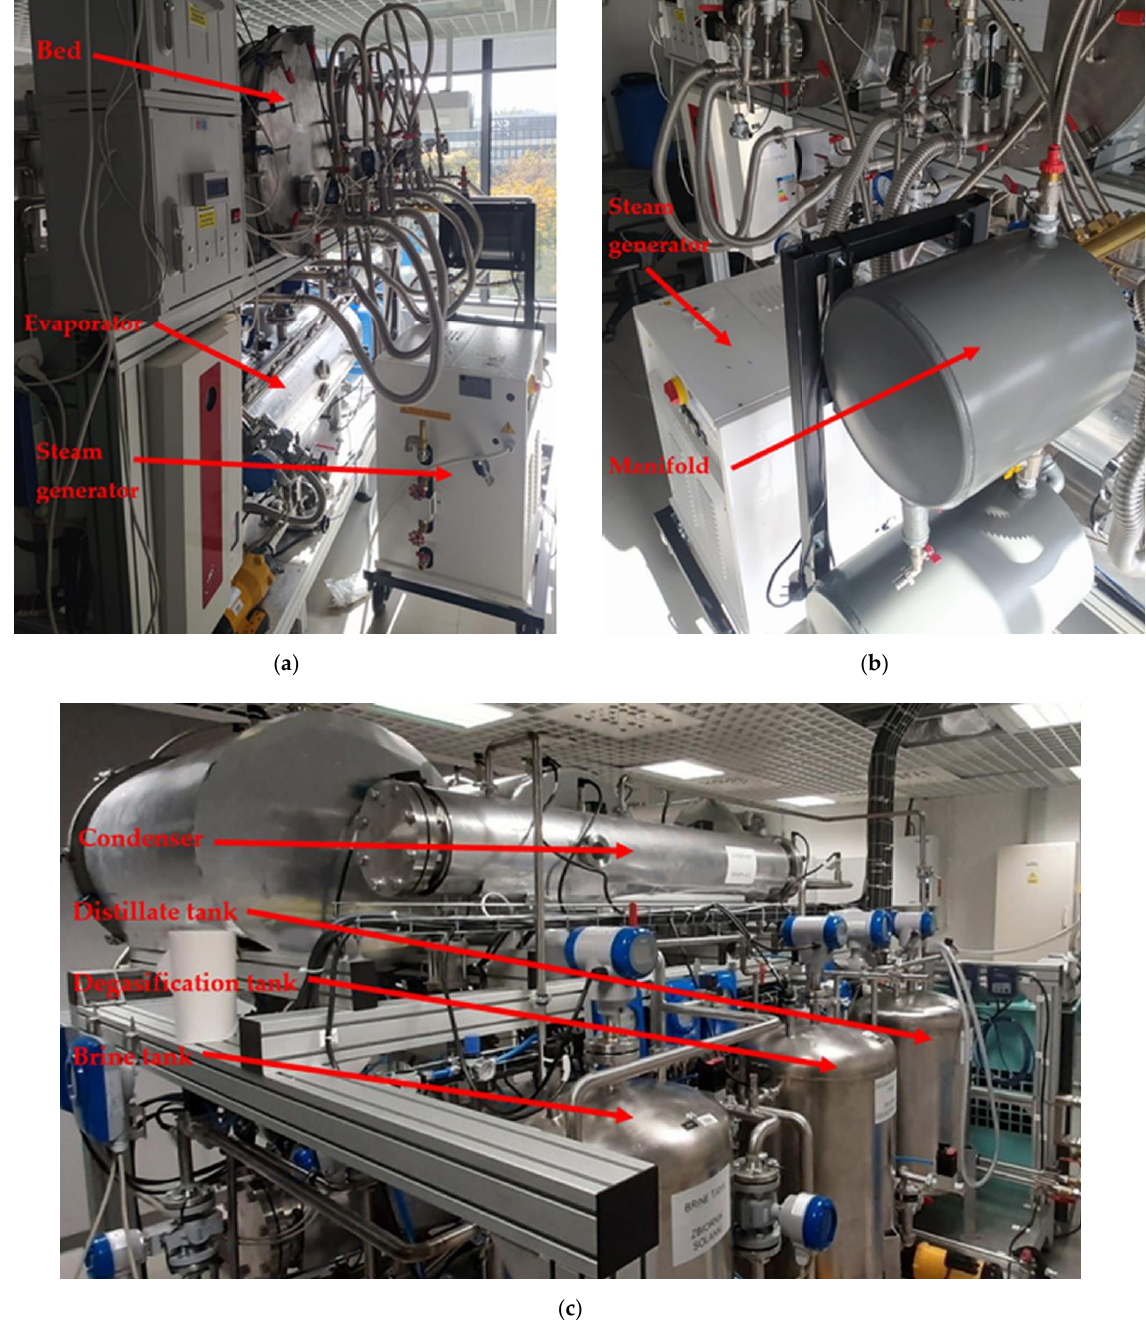
Figure 2. Pictures of the test stand: ( a ) front view on the beds, evaporator and steam generator; ( b ) front view on the steam generator and manifold; ( c ) back view on the condenser, distillate tank, degasification tank and brine tank.